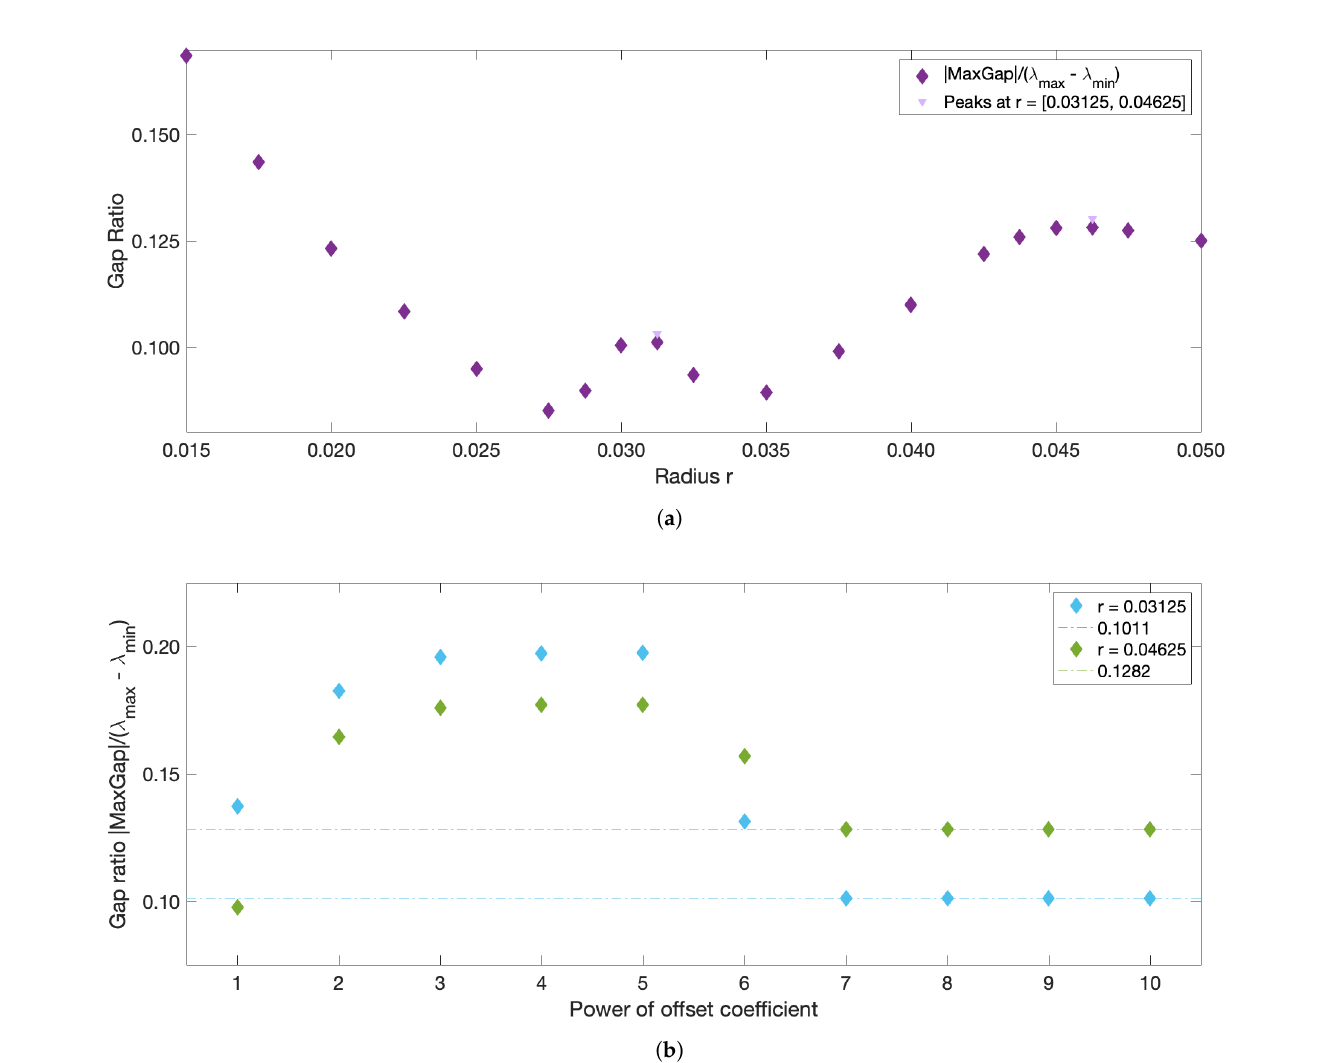
Figure A6. Steps 1 and 2 of the spectral clustering protocol for the 2018 No Man’s Land 04:00–10:00 experiment. ( a ) Sweep of r parameters with offset coefficient 10 7 for the average distance function. ( b ) Sweep of offset coefficients 10 n for average distance function and the normalized eigengap peaks from ( a